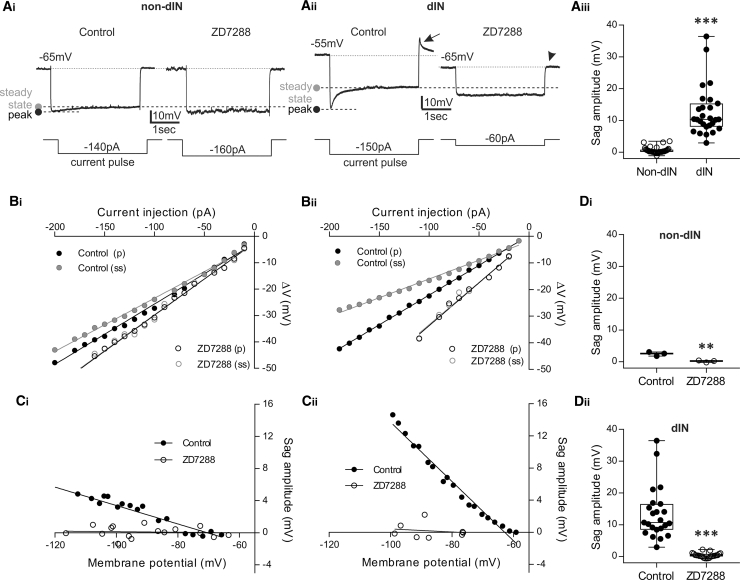
Ih Is Present in All dINs and in Some Non-dINs and Is Blocked by ZD7288(A) An example of a sag potential in a non-dIN (Ai) with and without ZD7288 (50 μM). The peak and steady-state membrane potential responses are indicated by dashed lines. (Aii) An example response of a dIN to hyperpolarizing current pulses (3-s duration). ZD7288 (10 μM) hyperpolarized the RMP (see also Figure 3) and abolished the large sag potentials observed at hyperpolarized membrane potentials. Arrow, post-inhibitory depolarization seen in control; arrow head, the membrane potential rebound was absent in the presence of ZD7288. (Aiii) Pooled data showing a comparison of the sag amplitude between −80 and −90 mV in dINs (n = 27) and non-dINs (n = 34; ∗∗∗p < 0.001; median with 50% IQR displayed as box-and-whisker plots).(B) The voltage-current (V-I) relationship for a non-dIN (Bi) and a dIN (Bii) in response to hyperpolarizing current pulses (3-s duration) of increasing amplitude (10 pA incremental steps) and the effect of 10–50 μM ZD7288. For both control (closed circles) and in ZD7288 (open circles), the peak (p) and the steady-state (ss) membrane potential change are plotted against each injected current amplitude.(C) The amplitude of the sag potentials in a non-dIN (Ci) and a dIN (Cii) was plotted against the membrane potential with (open circles) or without (closed circles) ZD7288.(D) Pooled data showing that ZD7288 (10–50 μM) significantly abolished the sag potential observed around −80 mV. Data are expressed as median with 50% IQR and displayed as box-and-whisker plots with individual data points. (Di): 3 non-dINs, p = 0.0048; (Dii): 23 dINs, p < 0.001; ∗∗p < 0.01; ∗∗∗p < 0.001. See also Figure S2.